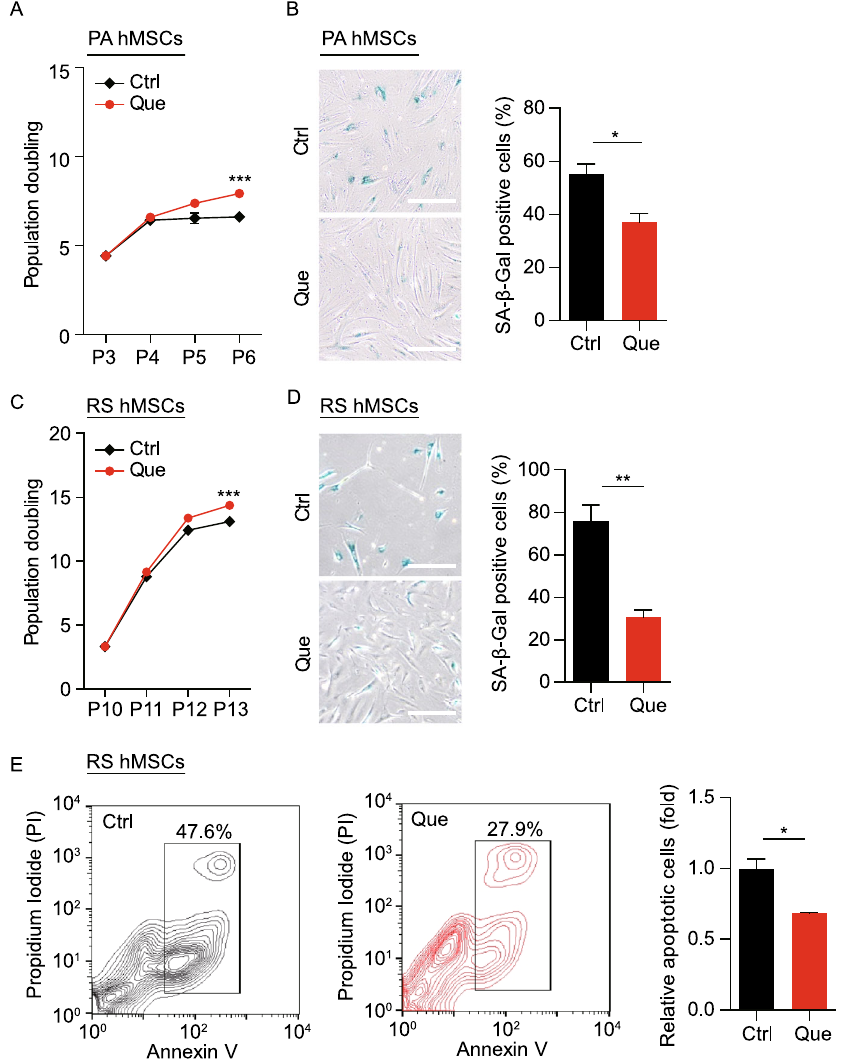
Figure 10. Que alleviated senescent phenotypes in physiological-aging (PA) hMSCs and replicative-senescent (RS) hMSCs. (A) Accumulative growth curve showing the population doubling of vehicle- and Que-treated PA hMSCs ( n = 3). *** P < 0.001 vs. Ctrl. (B) Analysis of SA- β -Gal activity in vehicle- and Que-treated PA hMSCs (passage 5). Left, representative images of SA- β -Gal staining; right, frequency of SA- β -Gal-positive cells. Data are shown as mean ± SEM ( n = 3). * P < 0.05 vs. Ctrl. Scale bar, 100 μ m. (C) Accumulative growth curve showing the population doubling of vehicle- and Que-treated RS hMSCs ( n = 3). *** P < 0.001 vs. Ctrl. (D) Analysis of SA- β -Gal activity in vehicle- and Que-treated RS hMSCs (passage 13). Left, representative images of SA- β -Gal staining; right, frequency of SA- β -Gal-positive cells. Data are shown as mean ± SEM ( n = 3). ** P < 0.01 vs. Ctrl. Scale bar, 100 μ m. (E) Cell apoptosis assay in vehicle- and Que-treated RS hMSCs (passage 13). Quantitative data on the right are shown as mean ± SEM ( n = 3). * P < 0.05 vs.